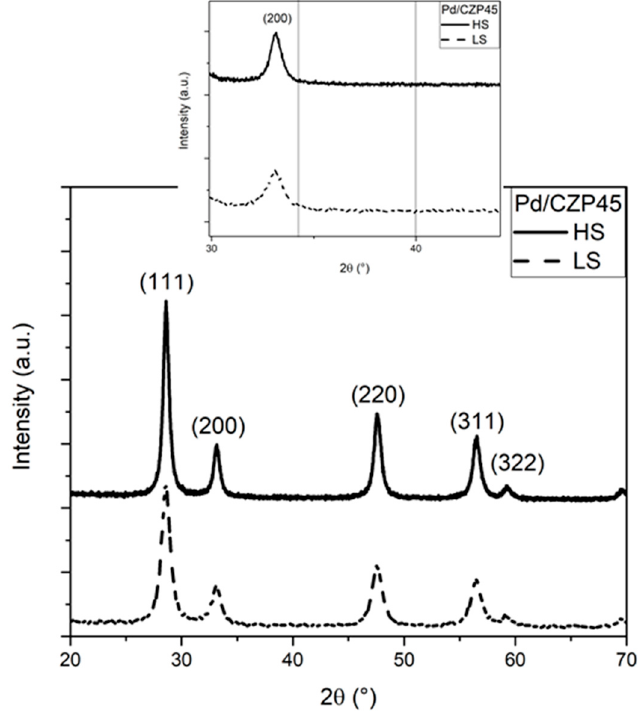
Figure 1. X-Ray diffractogram of Pd-HS and Pd-LS. The insert is a zoom in the 2 θ range of the main diffraction peaks of Pd and PdO (solid lines).